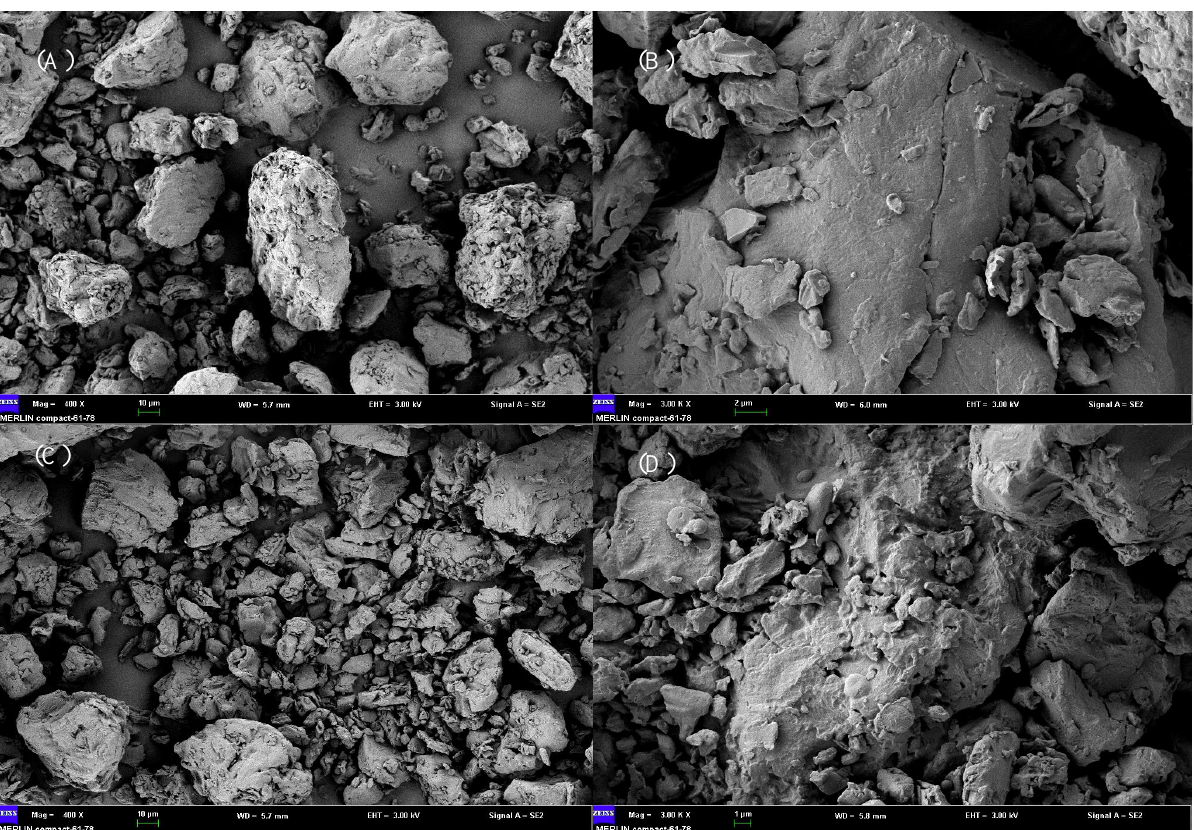
Figure 1. Scanning electron microscopy images of SBM and FSBM: ( A ) unfermented SBM (400×), ( B ) unfermented SBM (3000×), ( C ) FSBM (400×), ( D ) FSBM (3000×).